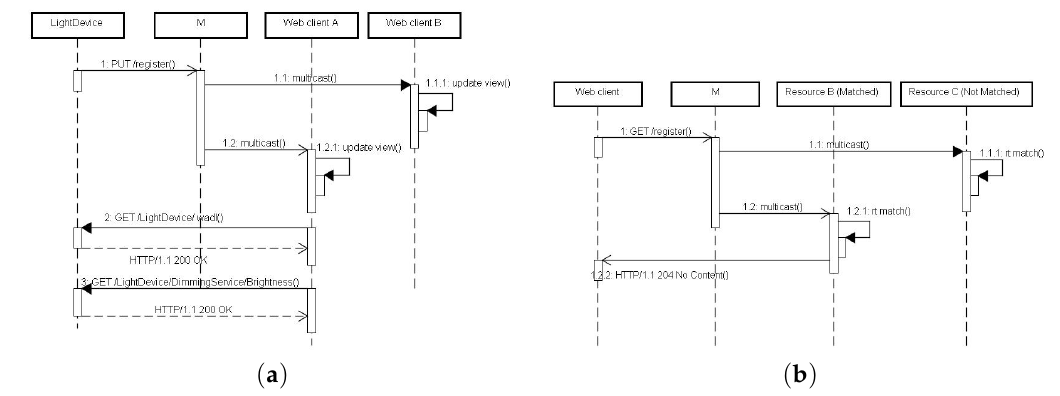
Figure 6. Proposed service management scheme: ( a ) ROSA presence announcement; ( b ) ROSA proactive